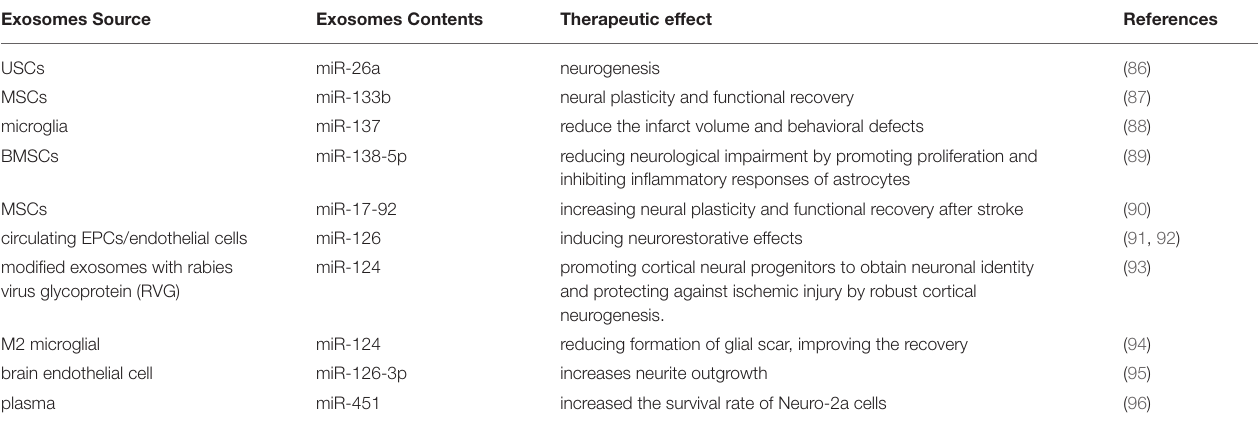
TABLE 2 | Exosomal miRNAs as therapeutic agents for ischemic